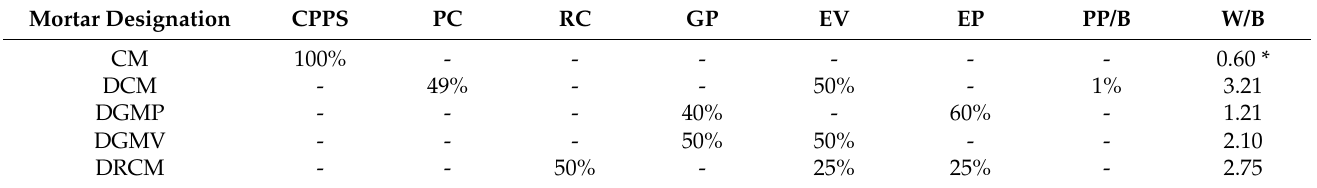
Table 2. Constitution of each selected mortar (amount of materials in volume %).